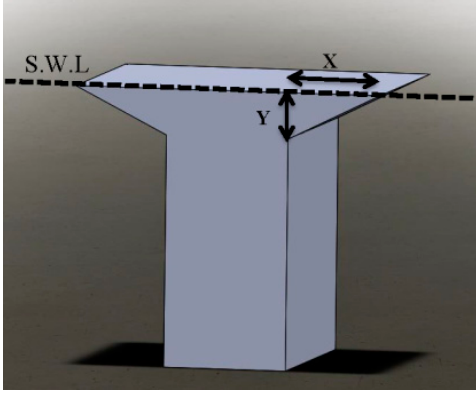
Figure 22. Optimization results of the upside filleted geometry: ( a ) all results, and ( b ) Pareto front.